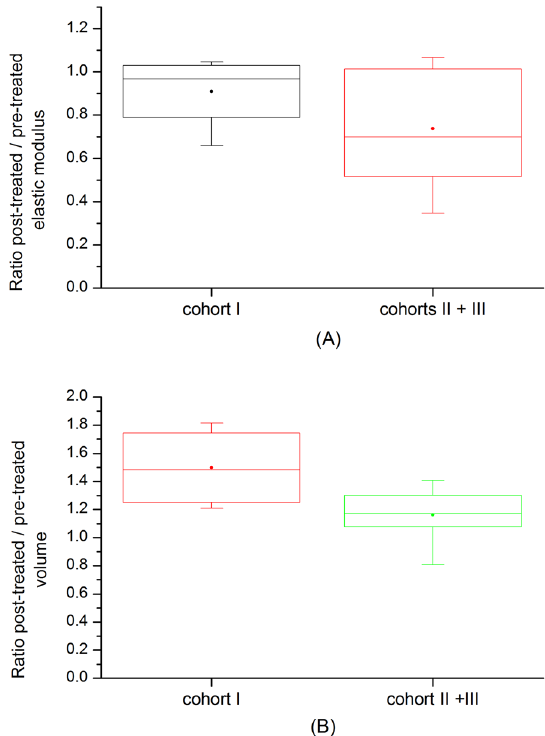
Figure 5. Ratio of post-treatment over pre-treatment tumour volume and elastic (Young’s) modulus. First post- treatment / last pre-treatment ratio of volume ( A ) and elastic modulus ( B ) in control and drug-treated group. The box extends from the 25th to 75th percentiles with min-max whiskers; the mean values are indicated by the dots.